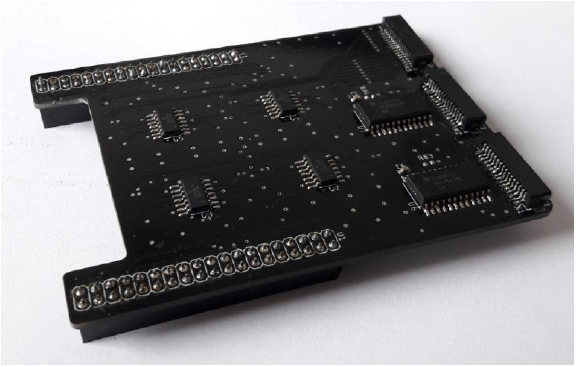
Figure 5. Expander board after assembly—top